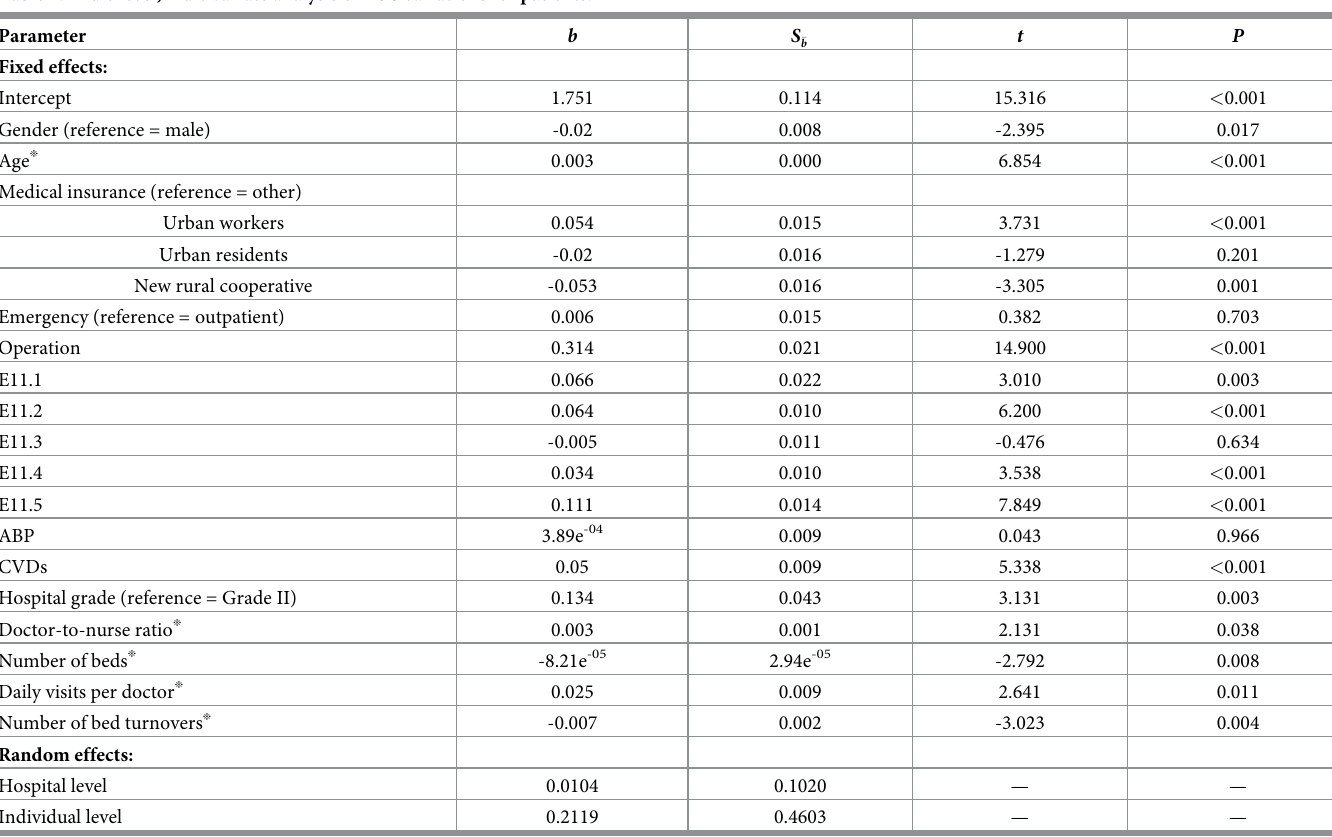
Table 4. Multilevel, multivariate analysis of LOS variations for